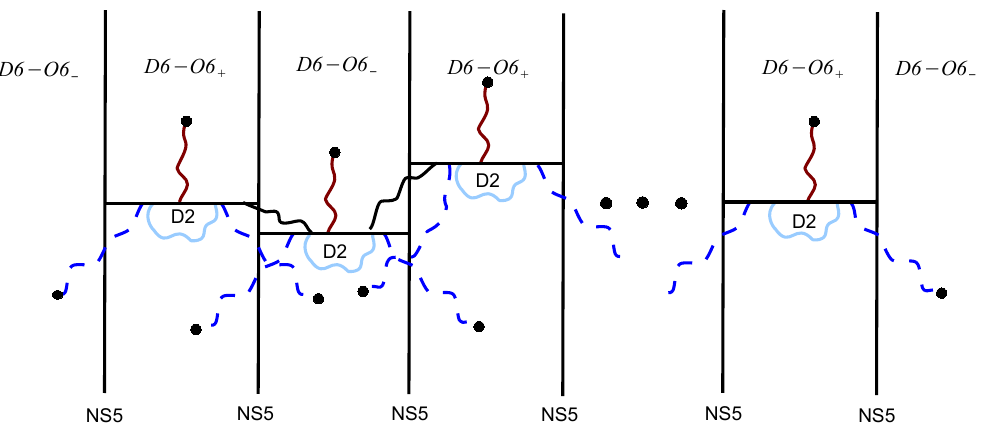
+4 a singularity. The